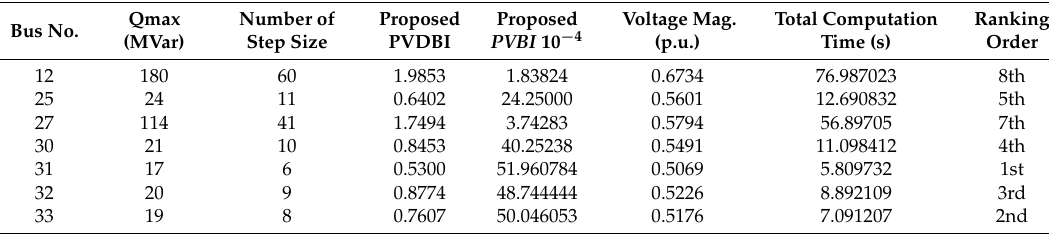
Table 10. Results of the proposed PVBI of the IEEE 57-bus power system. Bus No.